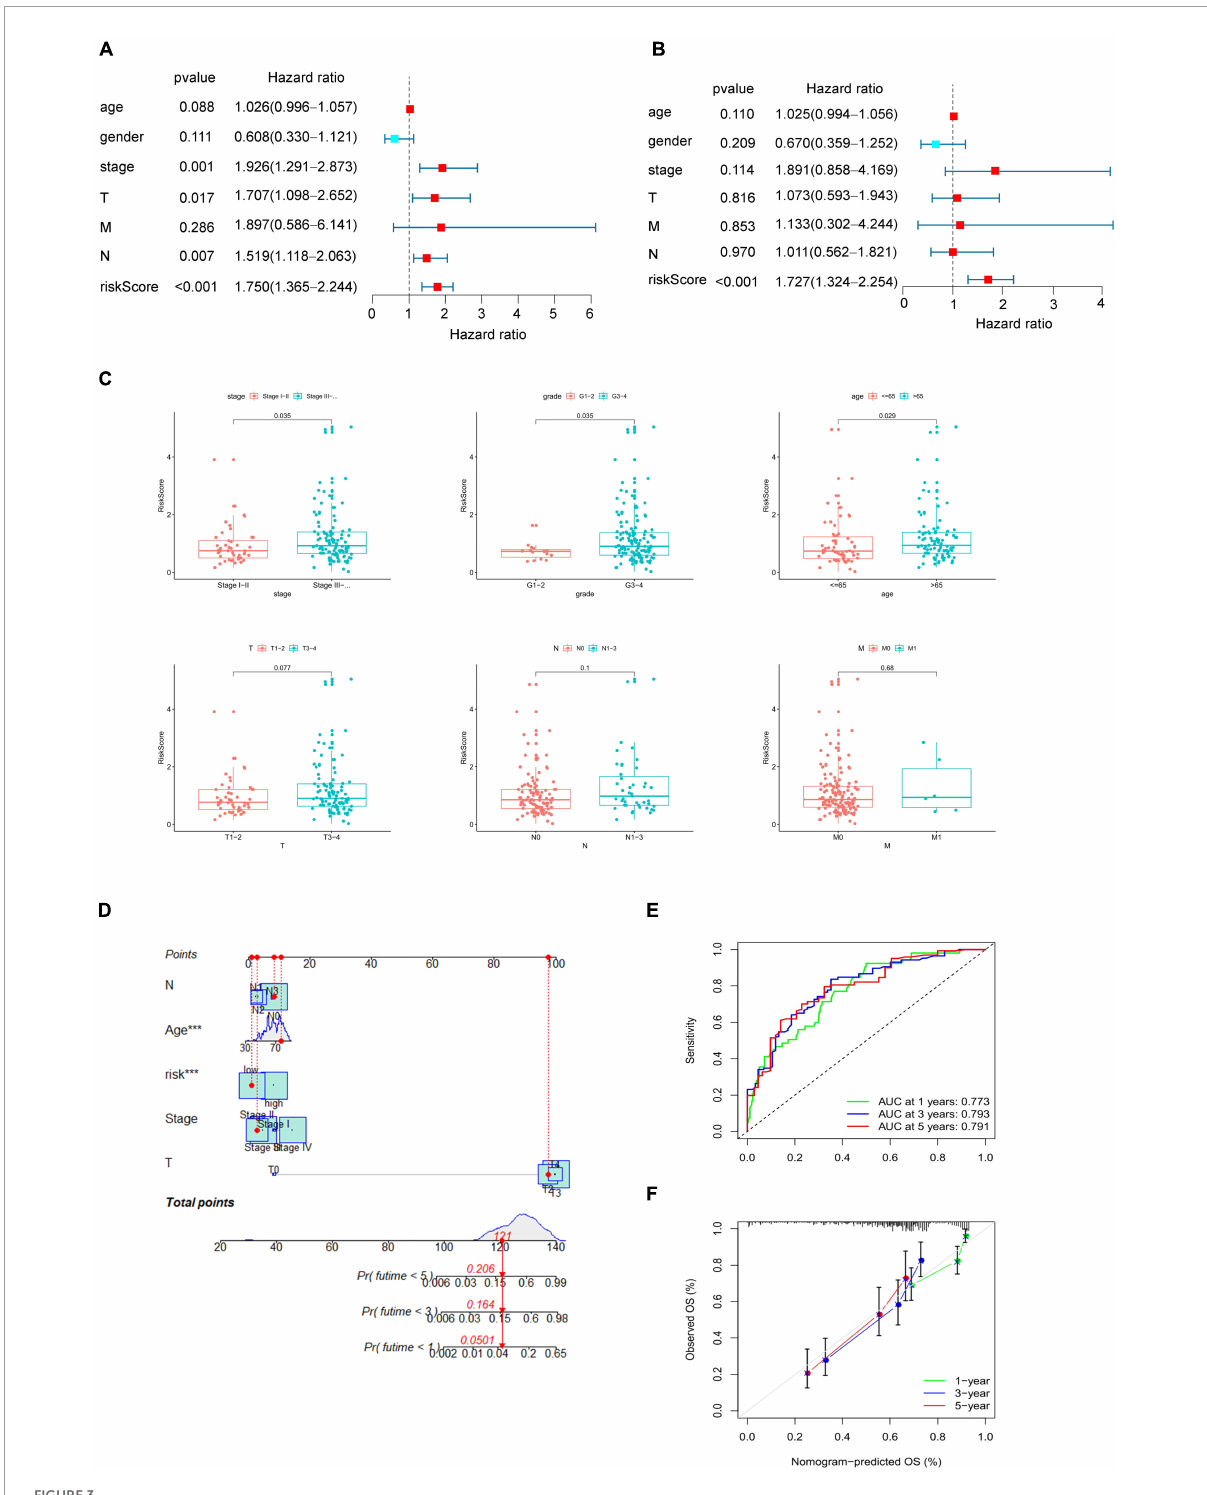
FIGURE3 Clinical correlation of the present model. (A) Univariate Cox regression analysis to identify prognosis associated factors. (B) Multivariate Cox regression analysis to assess independent prognostic factors. The red and blue dots represent variables with hazard ratio > 1 and ≤ 1, respectively. (C) Relationship between the risk score and clinical pathological stage, histological grade, age, TNM status. (D) Nomogram of eRNAs-based systematic signature. p < 0.05 was considered statistically significant. (E) ROC curves of nomogram for 1–, 3– 5–years overall survival prediction. (F) Calibration diagram for the